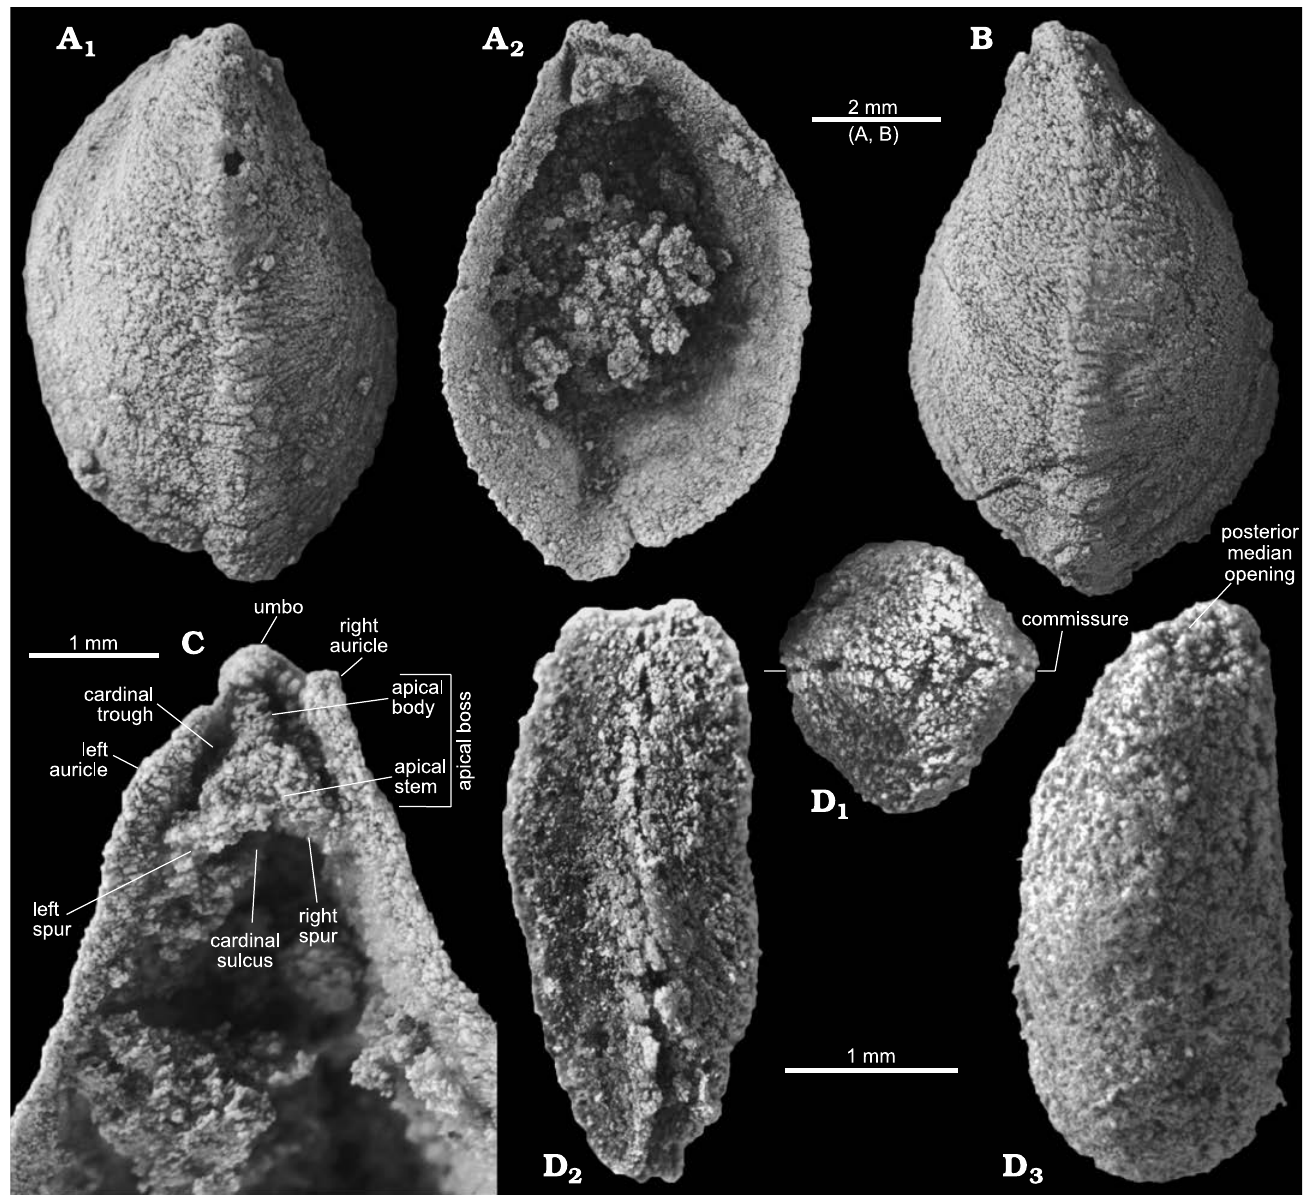
Fig. 4. Stenothecoid pan-brachiopod Stenothecoides rasettii sp. nov., middle Cambrian, Burgess Shale Formation, Yoho National Park, Canada, Locality 2 (A, B, D) and Locality 1 (C, D). A . TMP 2002.083.0176 (holotype), dorsal valve in exterior (A 1 ) and interior (A 2 ) views. B . TMP 2002.083.0177, ventral valve in exterior view. C . TMP 2008.024.1147, dorsal valve, internal apical area. D . TMP 2008.024.1122, articulated juvenile, dorsal/ventral (uncertain) valve in posterior (D 1 ), lateral (D 2 ), and oblique planar (D 3 ) views; D 1 and D 3 show posterior median opening, D 2 shows slightly sinusoidal